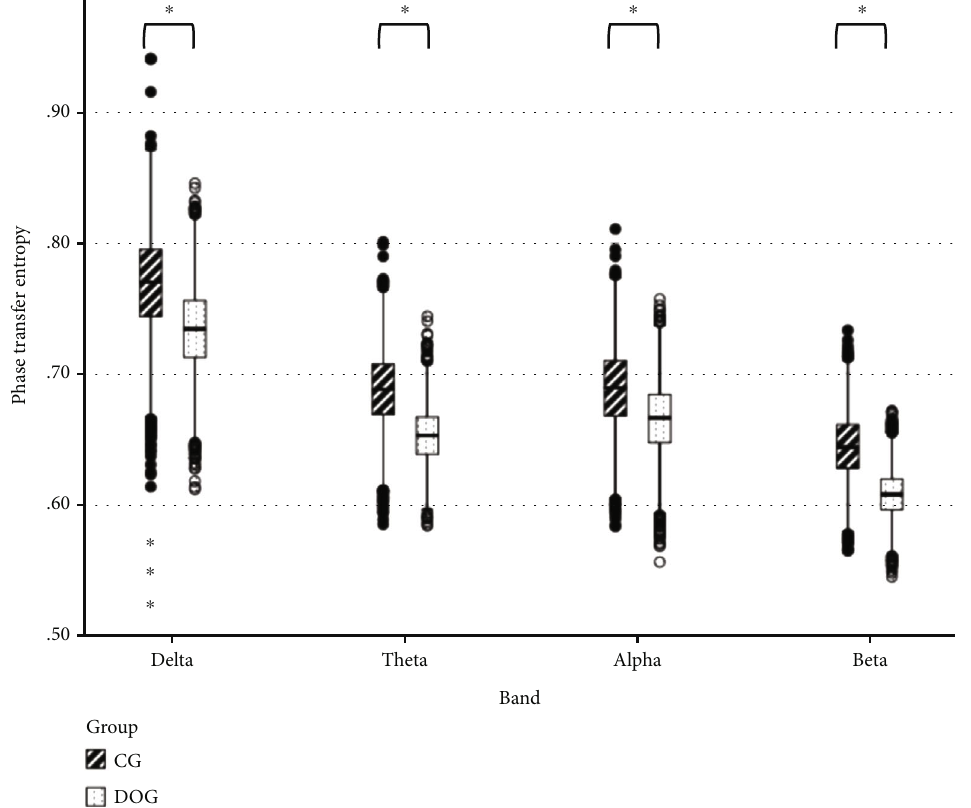
Figure 9: PTE results using Mann – Whitney U test. Delta, theta, alpha, and beta bands are statistically signi fi cant. ( ∗ represents P < 0 : 05 ) (PTE: phase transfer